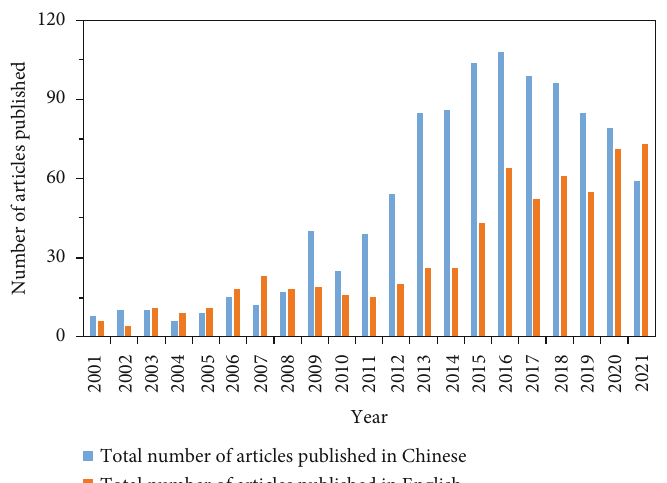
Figure 1: Statistical histogram of literatures related to the study of the Lower Cambrian shales and shale gas in China. The data of Chinese articles (blue column) comes from the “ CNKI, ” the data of English articles (orange column) comes from the “ ScienceDirect. ” The search methods are all through title, abstract, and keywords.